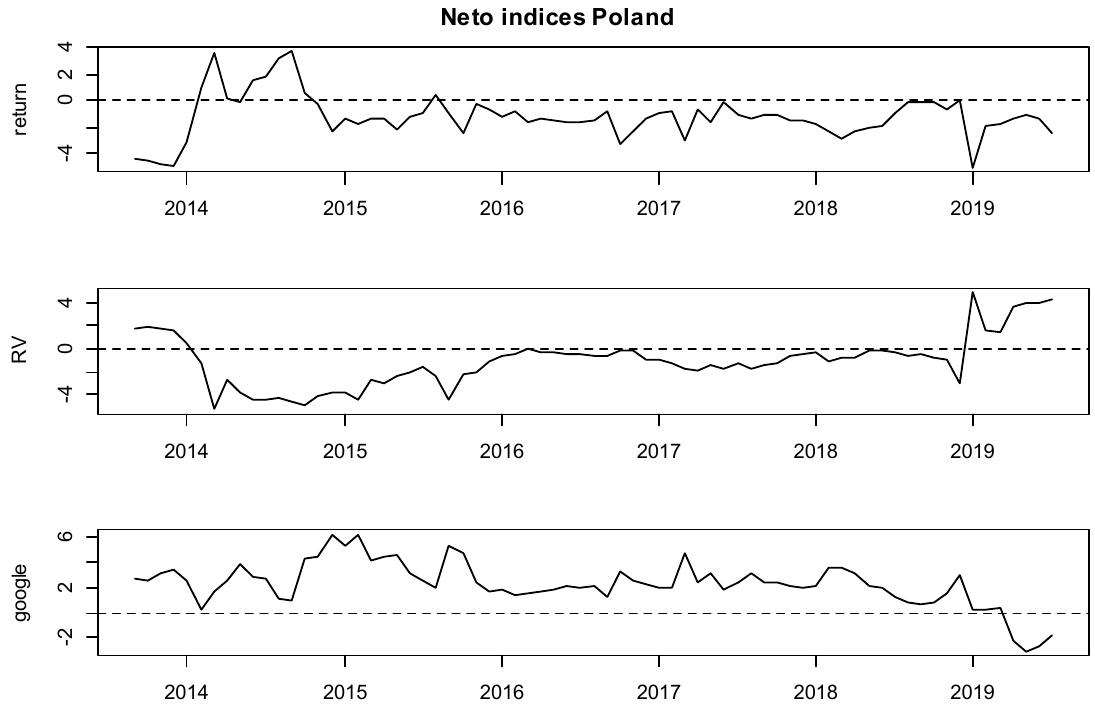
Figure 10. Net rolling indices, Bulgaria.